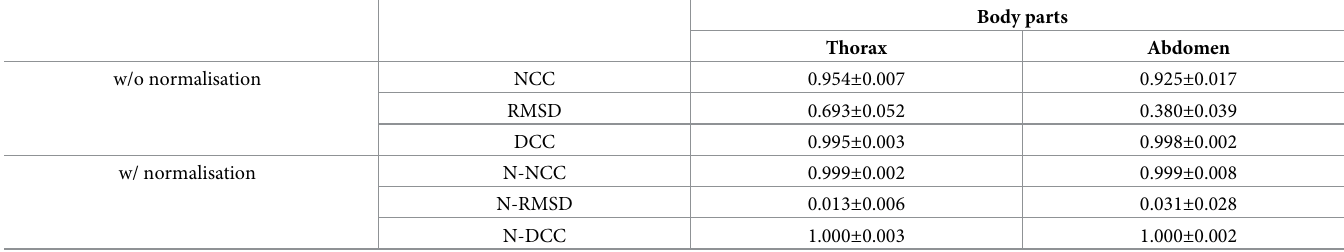
Table 2. The averaged value of the quantitative indicators for thoracic and abdominal regions from BHCT